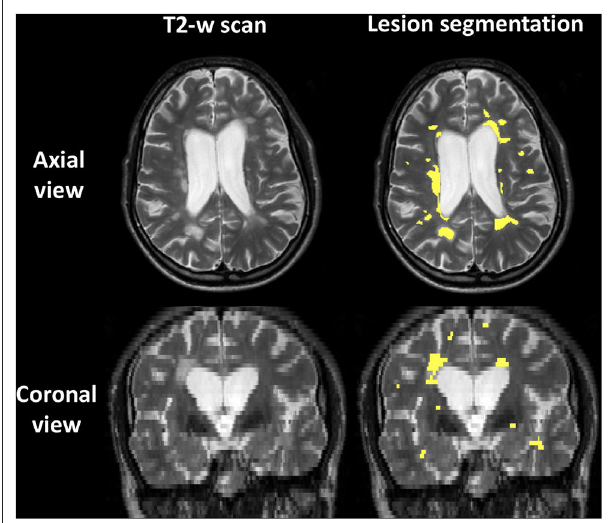
FIGURE 1 | Example of lesion segmentation on the T2-weighted fast spin echo 2D anatomical scan of one patient. Top : axial views; bottom : coronal views. Left : scan; right : scan with lesions outlined in